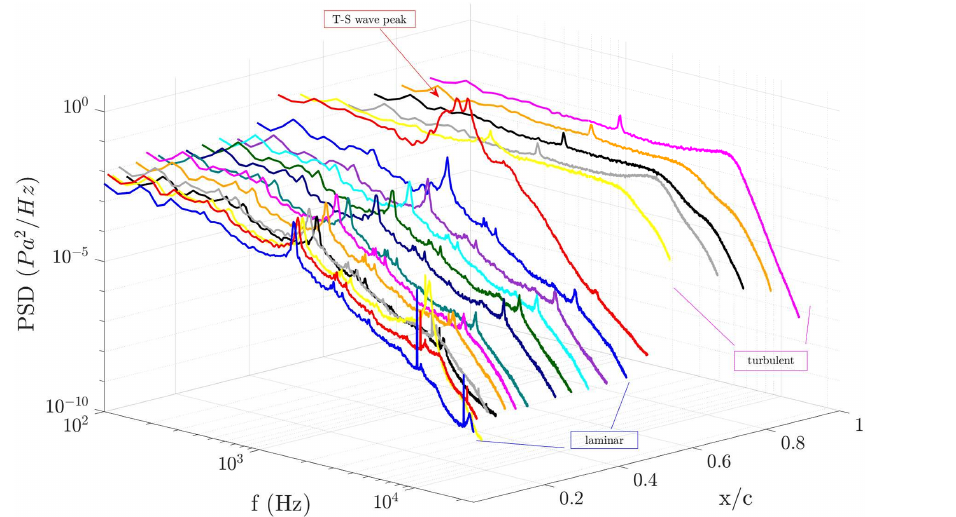
Figure 1. Chordwise power spectral density based on the pressure on the lower side of the airfoil, Re = 3 × 10 6 , AOA = 0 ◦ (Özçakmak, 2020).